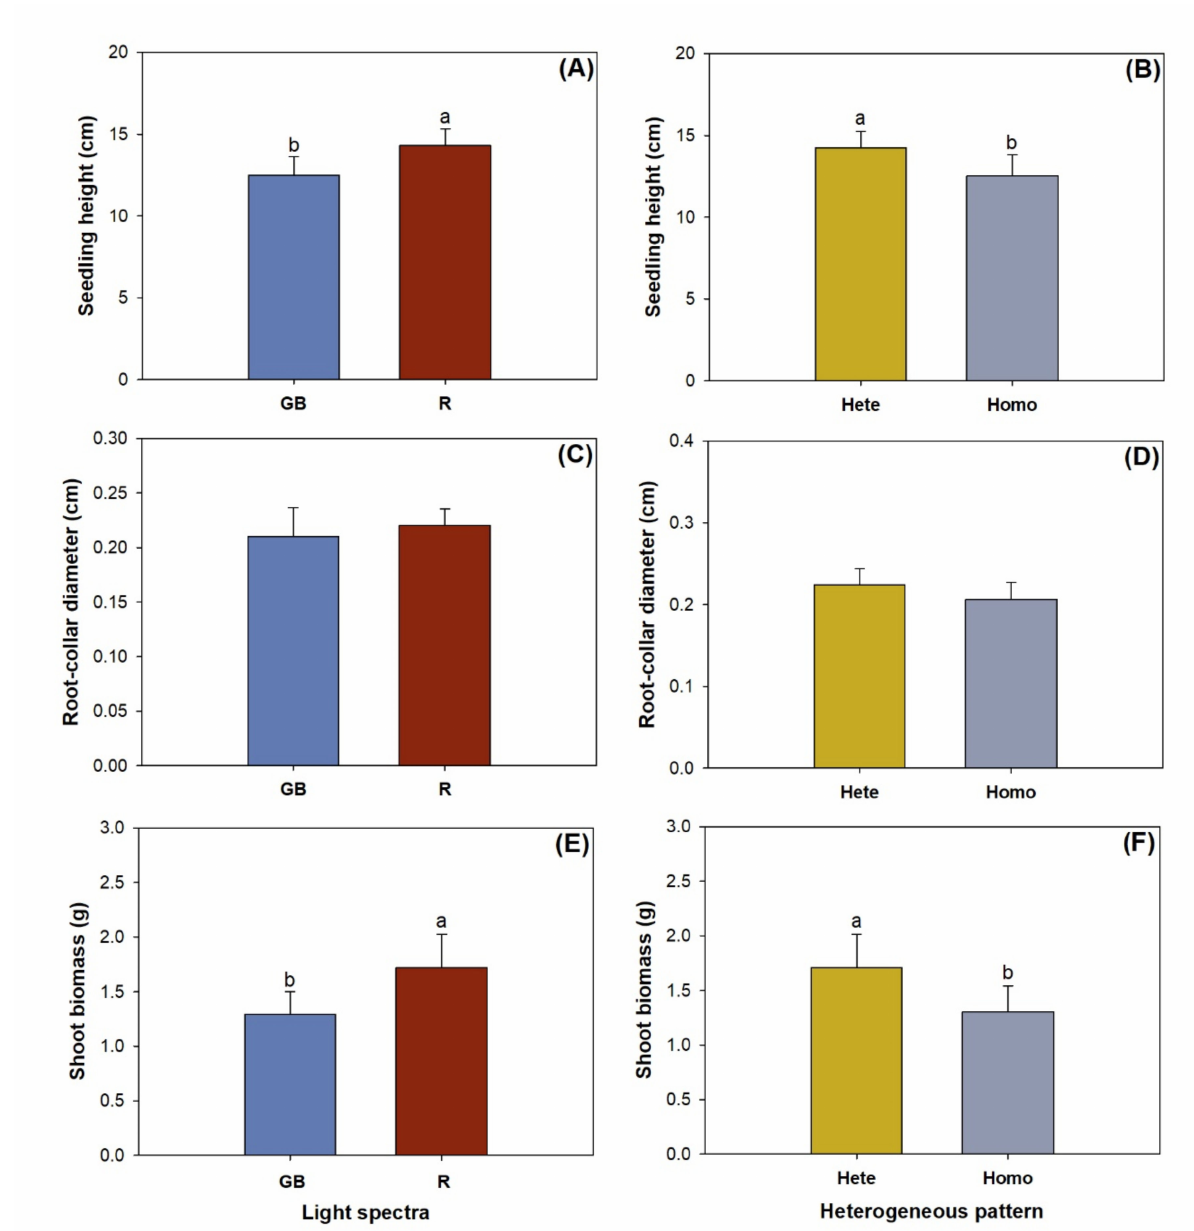
Figure 2. Seedling height ( A , B ), root-collar diameter ( C , D ), and shoot biomass ( E , F ) in Pinus pumila seedlings subjected to green-and-blue light (GB) and red-light enriched spectra (R) in heterogeneous (Hete) and homogeneous (Homo) nutrient patterns. Error bars indicate standard deviations. Different letters above the bars indicate significant differences according to Duncan test at the 0.05